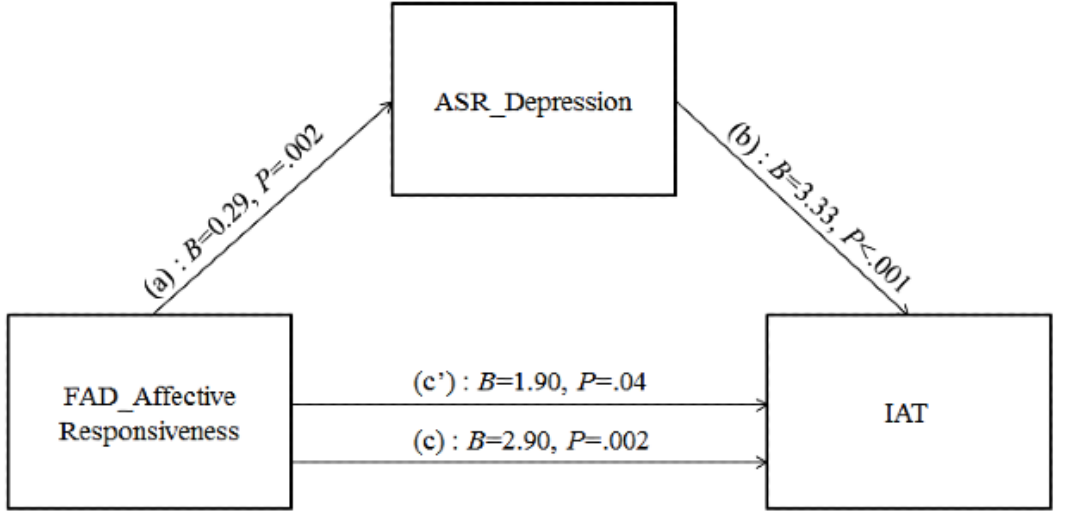
Figure 1. Simple mediation model for depressive problems mediating the association between affective responsiveness and internet addiction. (a) Direct effect of affective responsiveness on depression; (b) direct effect of depression on internet addiction test (IAT) score; (c’) direct effect of affective responsiveness on IAT score; (c) total effect (a*b+c’) of affective responsiveness on IAT score. ASR: Adult Self-Report; FAD: Family Assessment Device; IAT: internet addiction